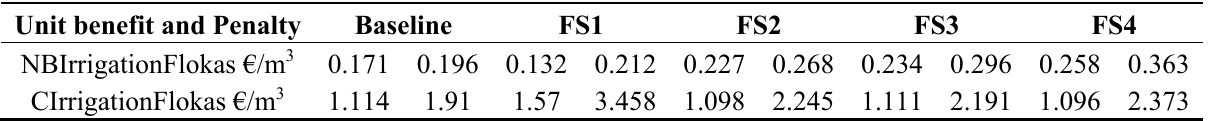
Table 14. Unit benefit ( NBIrrigationFlokas) and unit penalties ( CIrrigationFlokas ) for water allocated to irrigation, €/m 3 , for the baseline and the future scenarios for the application of the